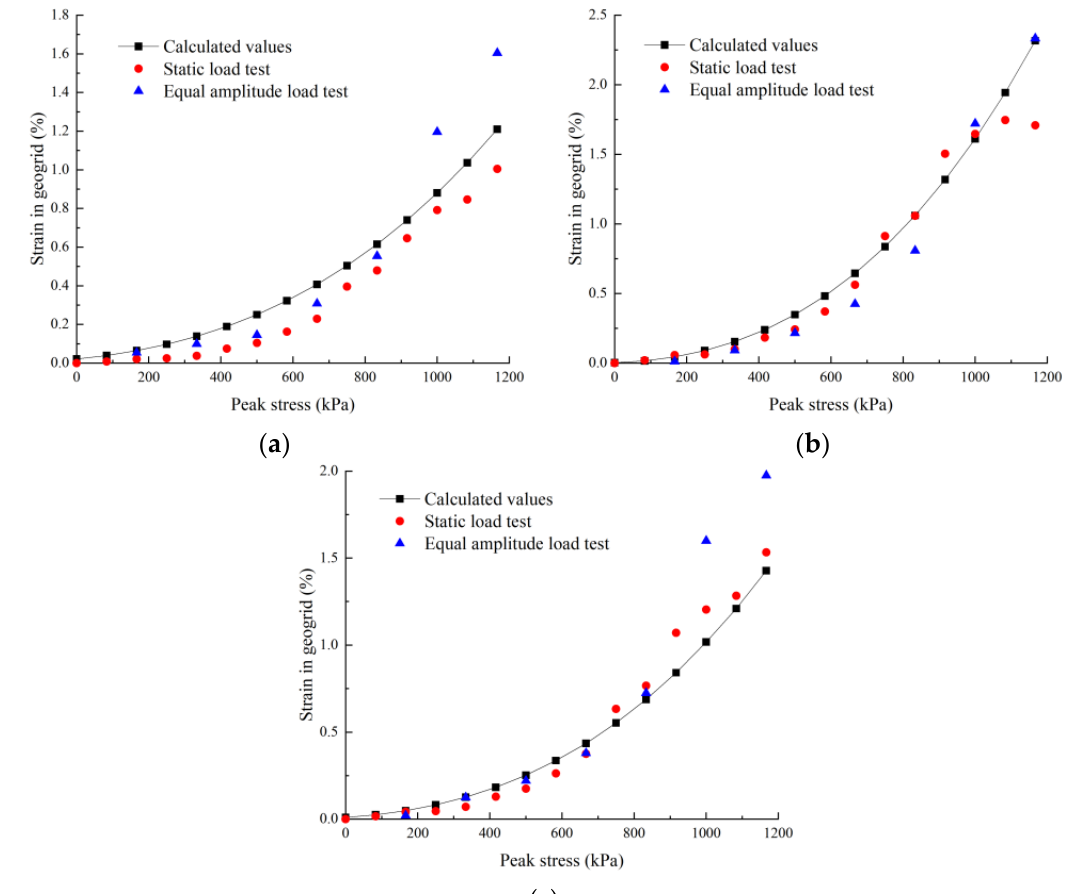
Figure 17. Comparison of calculated and test values. ( a ) Layer 1 geogrid . ( b ) Layer 2 geogrid . ( c ) Layer 3 geogrid .